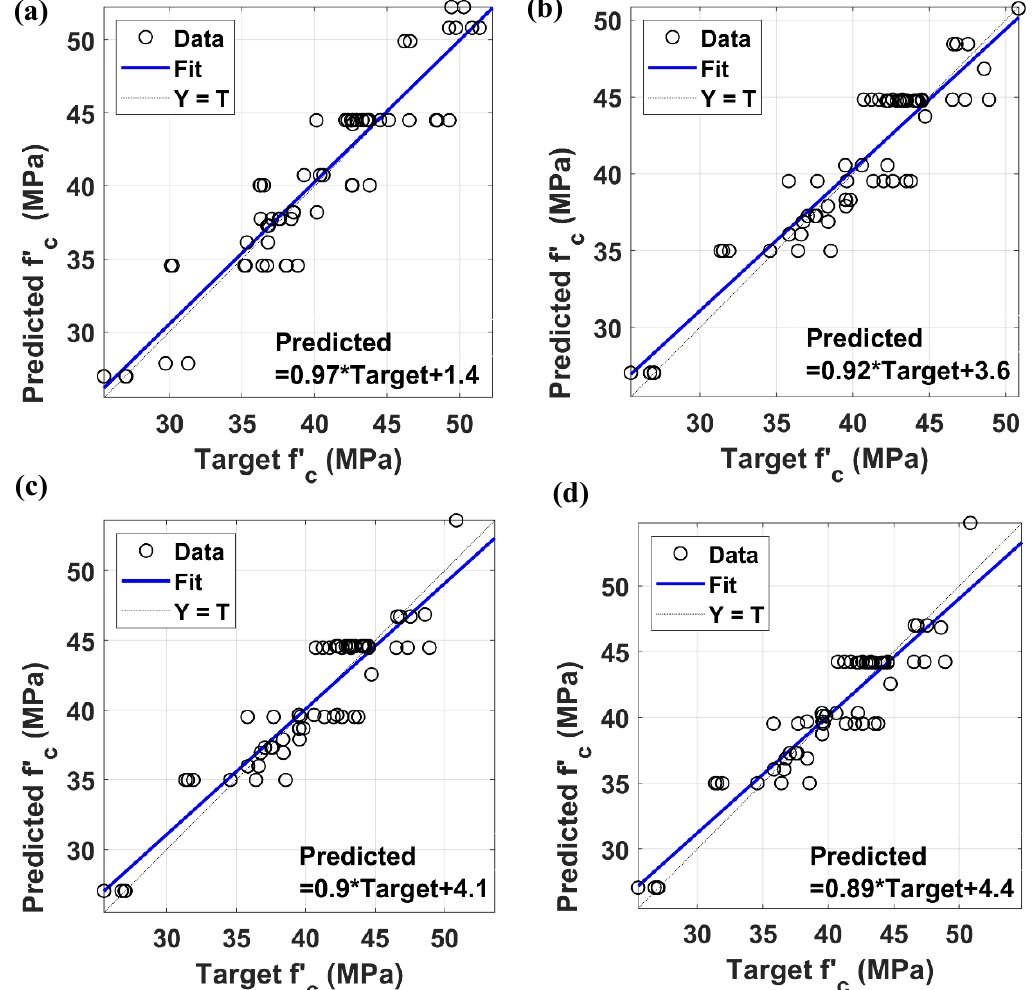
Figure 10. Correlation results analysis of ANFIS model using three input parameters: ( a ) Testing Fly Ash + Na 2 SiO 3 + NaOH, ( b ) testing Fly Ash + Na 2 SiO 3 + H 2 O, ( c ) testing Fly Ash + NaOH + H 2 O, and ( d ) testing Na 2 SiO 3 + NaOH + H 2 O.